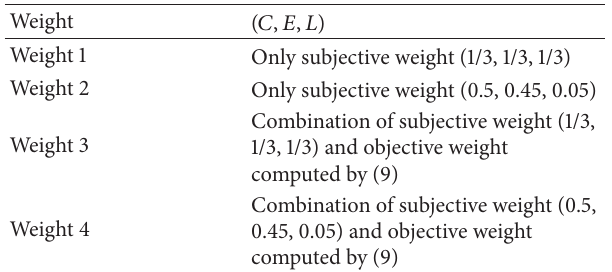
Table 7: Utility used for load balance simulation. Table 8: Weight for network